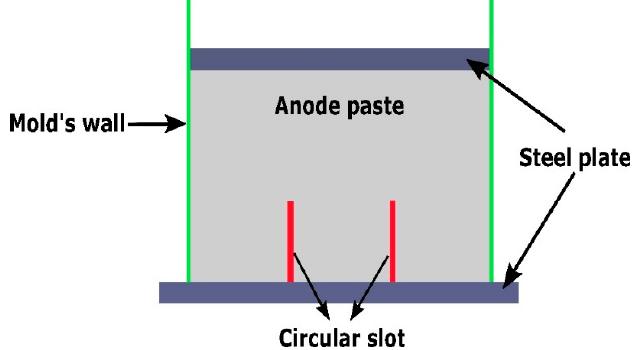
Figure 8. Cross-sectional view of the compaction test with the slot.